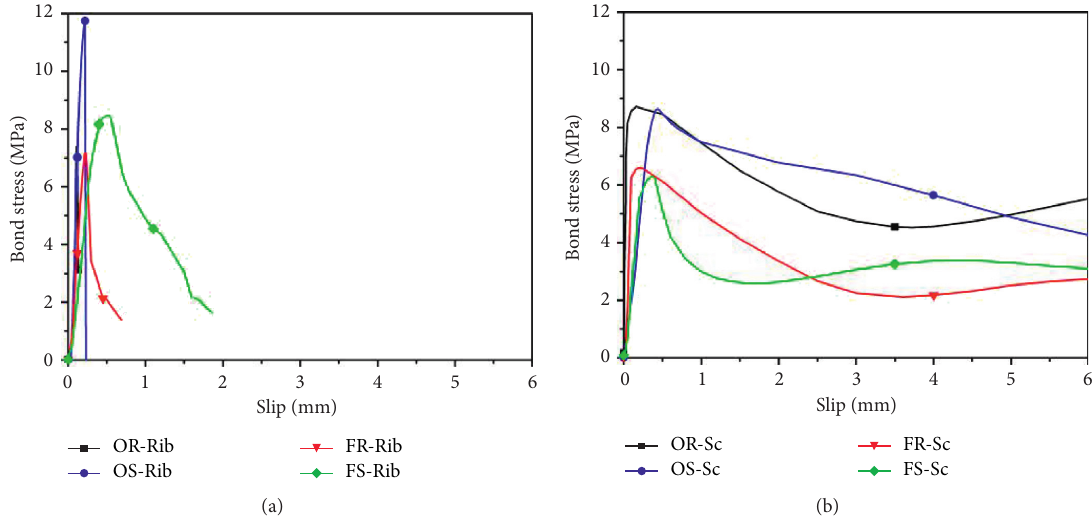
Figure 6: Typical bond-slip curves for specimens with (a) ribbed rebar and (b) sand coated